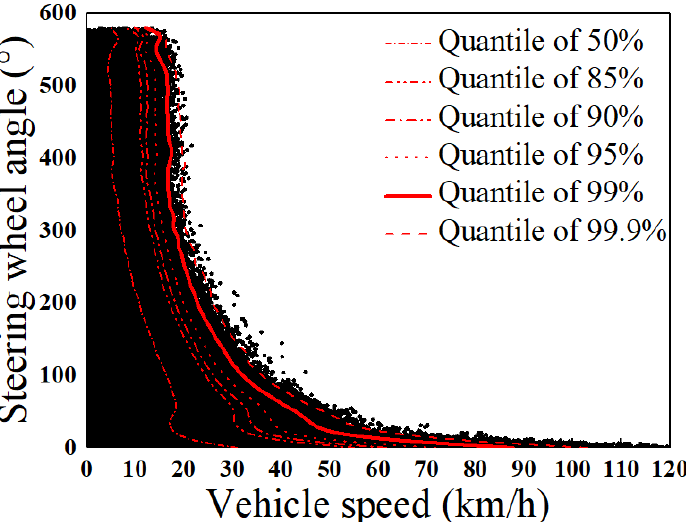
Figure 13. The comparison of distribution and quantile for steering wheel angle at different speeds.